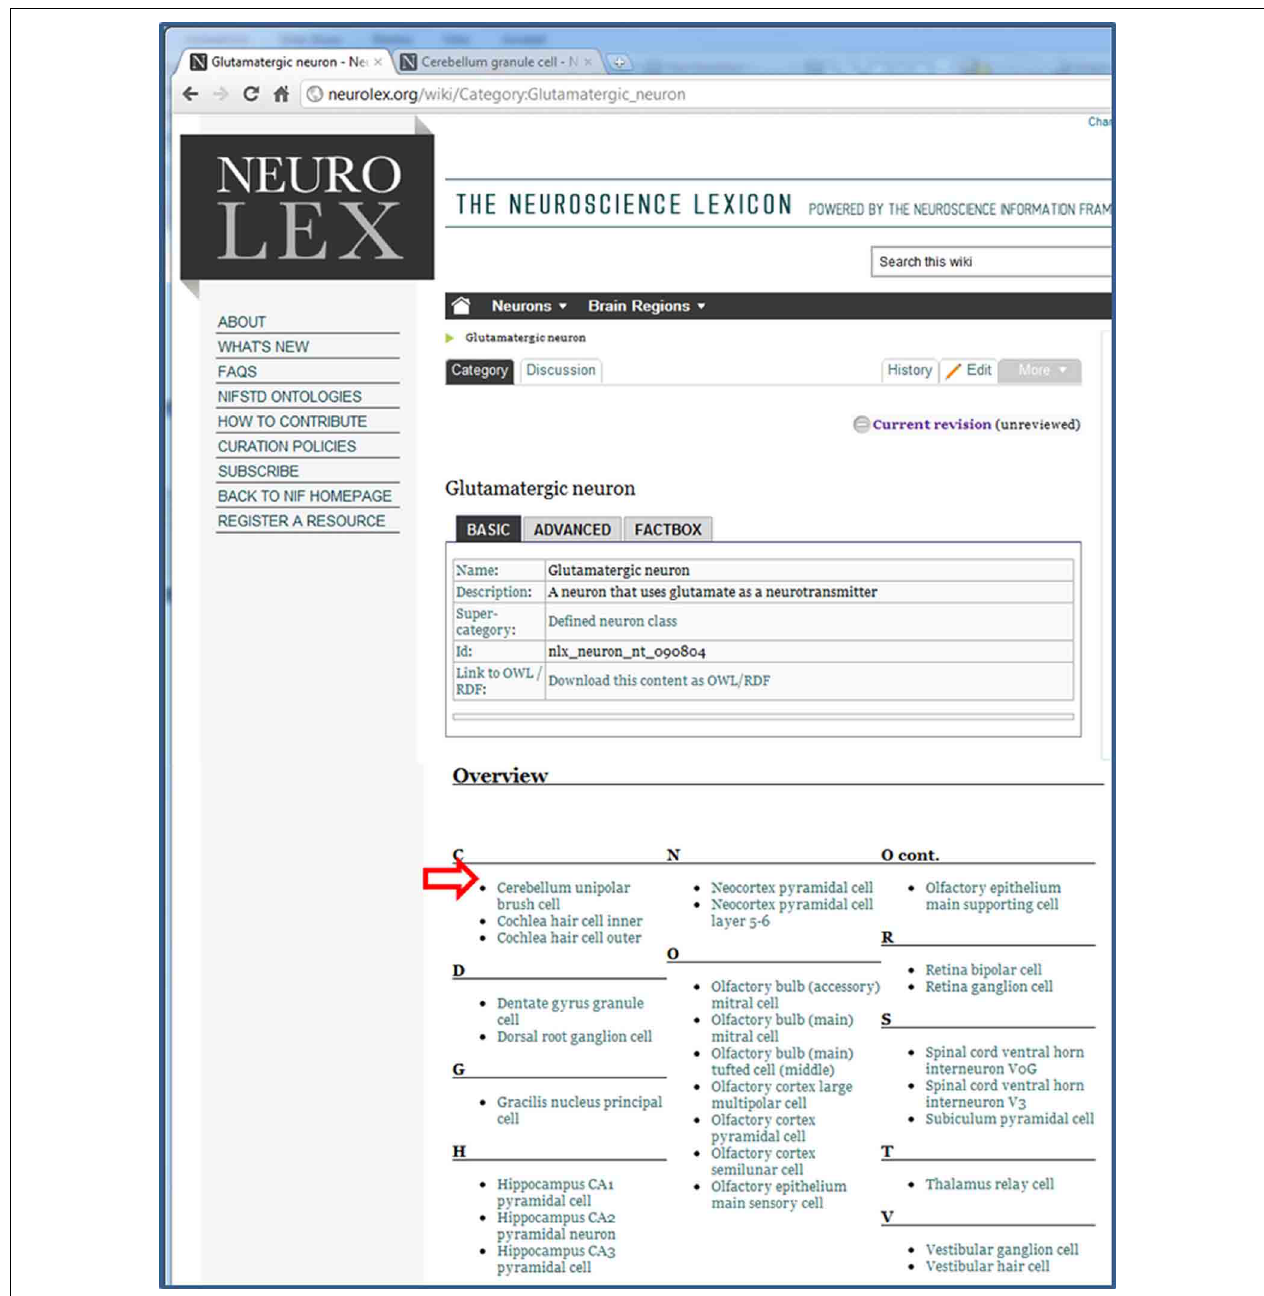
FIGURE 7 | The page for all Glutamatergic neurons. This page is a defined neuron class, which means that it is a collection of neurons that come together as a result of a shared property, the presence of